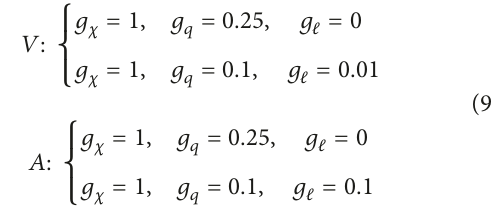
Figure 2: Feynman diagrams for the production of a DM pair in association with a quark or a gluon, leading to a mono-jet signature. Additional diagrams obtained by exchanging a fermion and a anti- fermion,aswellastheonesobtainedbypermutingthegluonvertices in the loop in the (pseudo)scalar case, are neglected. The diagrams enclosed in the dashed box in the 𝑡 -channel model are suppressed in the EFT